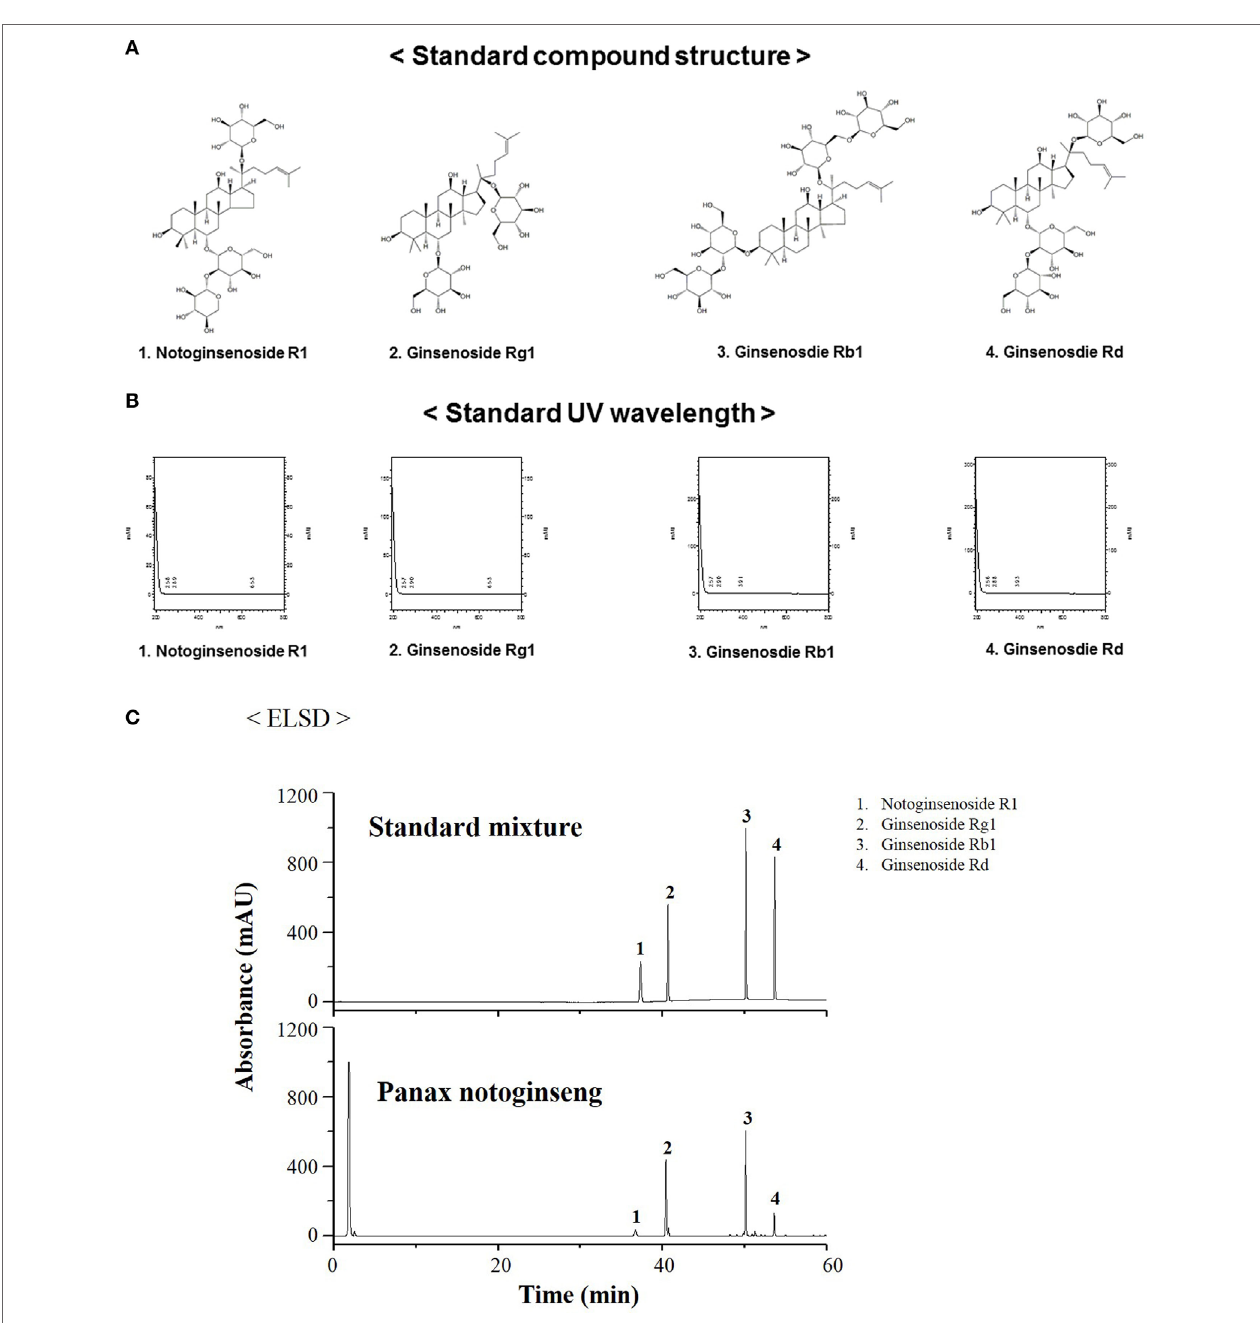
FigUre 1 | Measurement of the representative components of Panax notoginseng root (PNR) by high-performance liquid chromatography. Standard compound structure (a) , standard UV wavelength (B) , notoginsenoside R1 (1), ginsenoside Rg1 (2), ginsenoside Rb1 (3), and ginsenoside Rd (4) in the standard mixture (B) , and PNR (c) at a wavelength of 245